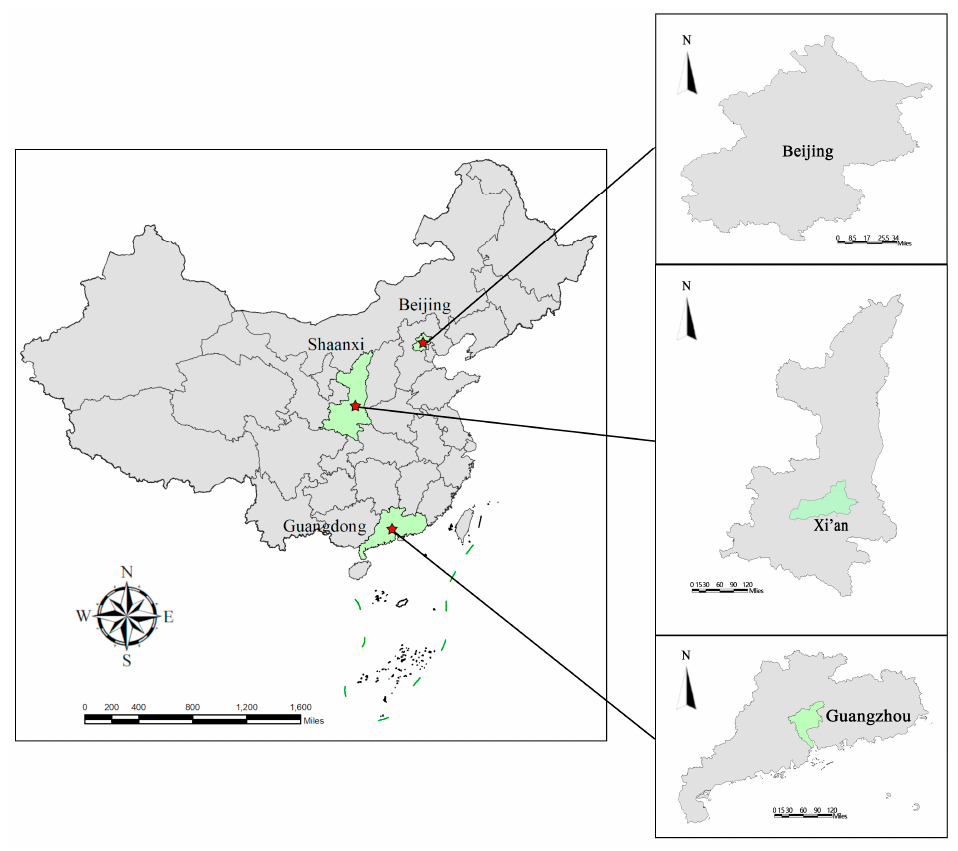
Figure 2. Locations selected for conducting the questionnaire.